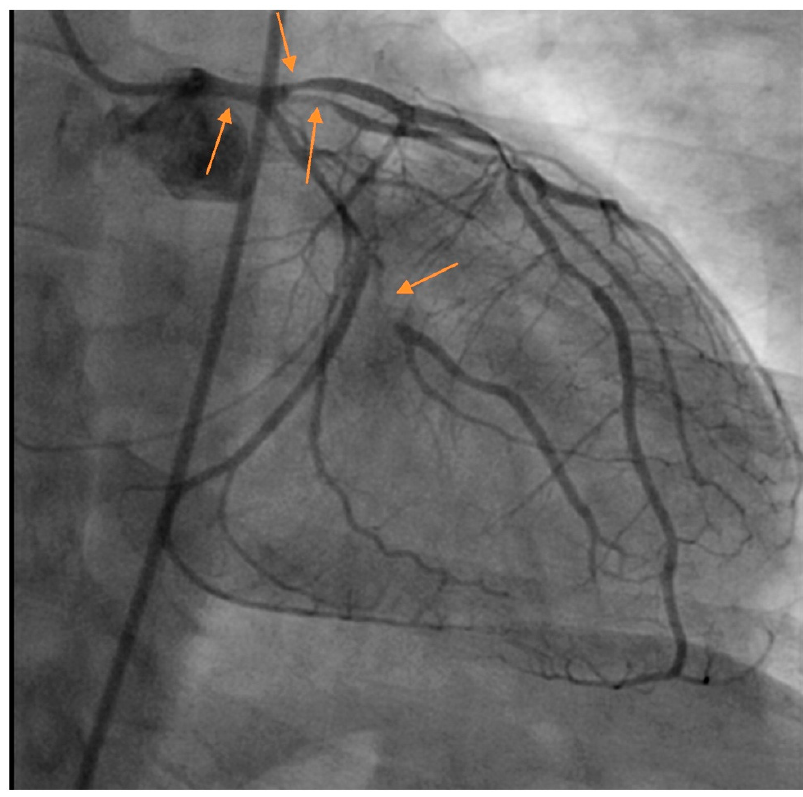
Figure 1. Multivessel spontaneous coronary artery dissection (SCAD) in a postpartum female presenting with acute coronary syndrome (ACS). Arrows denote areas of dissection. Images courtesy of Steven Cohen, M.D.